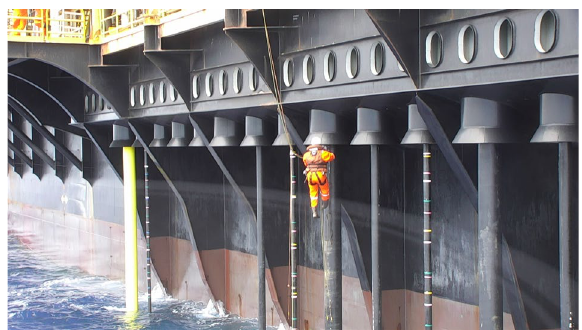
Figure 1. Industrial climbing for riser